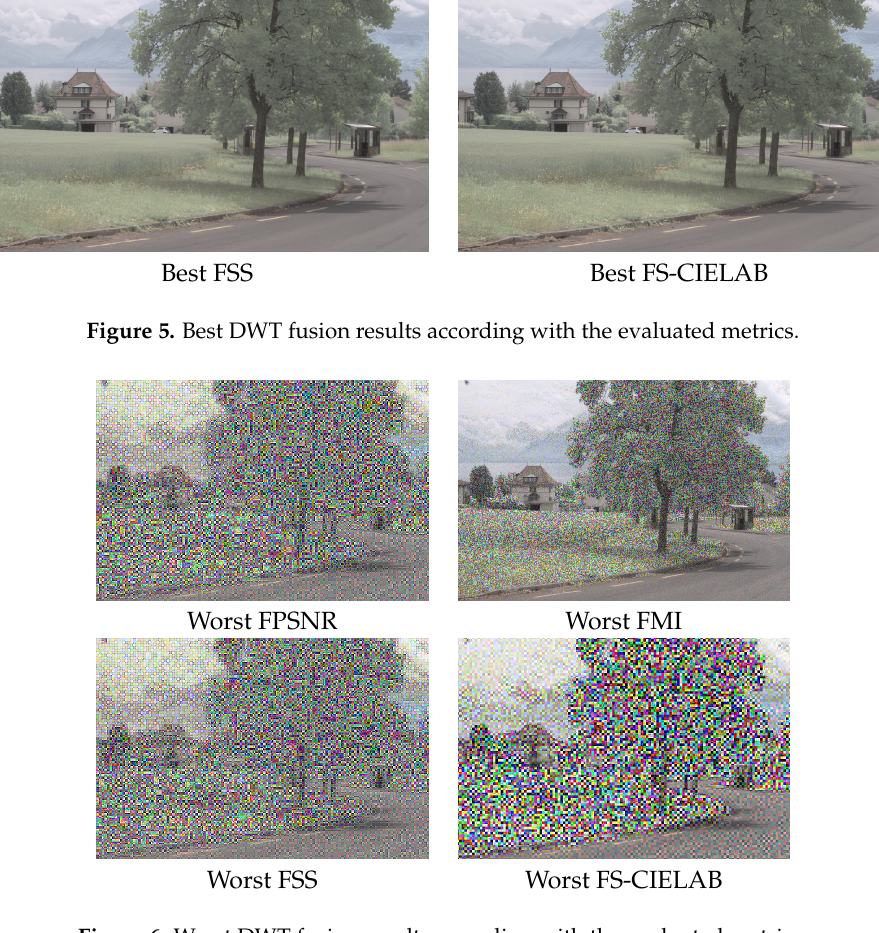
Figure 6. Worst DWT fusion results according with the evaluated metrics.